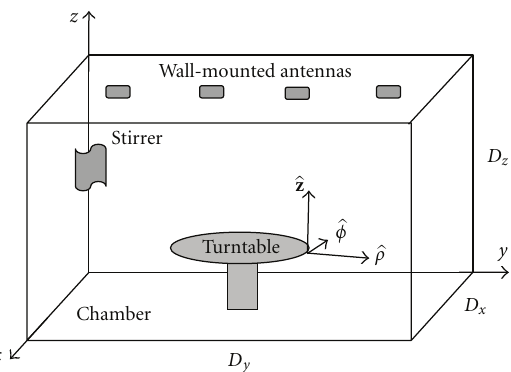
Figure 8: Rectangular reverberation chamber with dimensions D x , D D y , and z . The chamber contains four wall-mounted transmitting antennas, a mechanical stirrer, and a turntable. The DUT position is near the edge of the turntable.